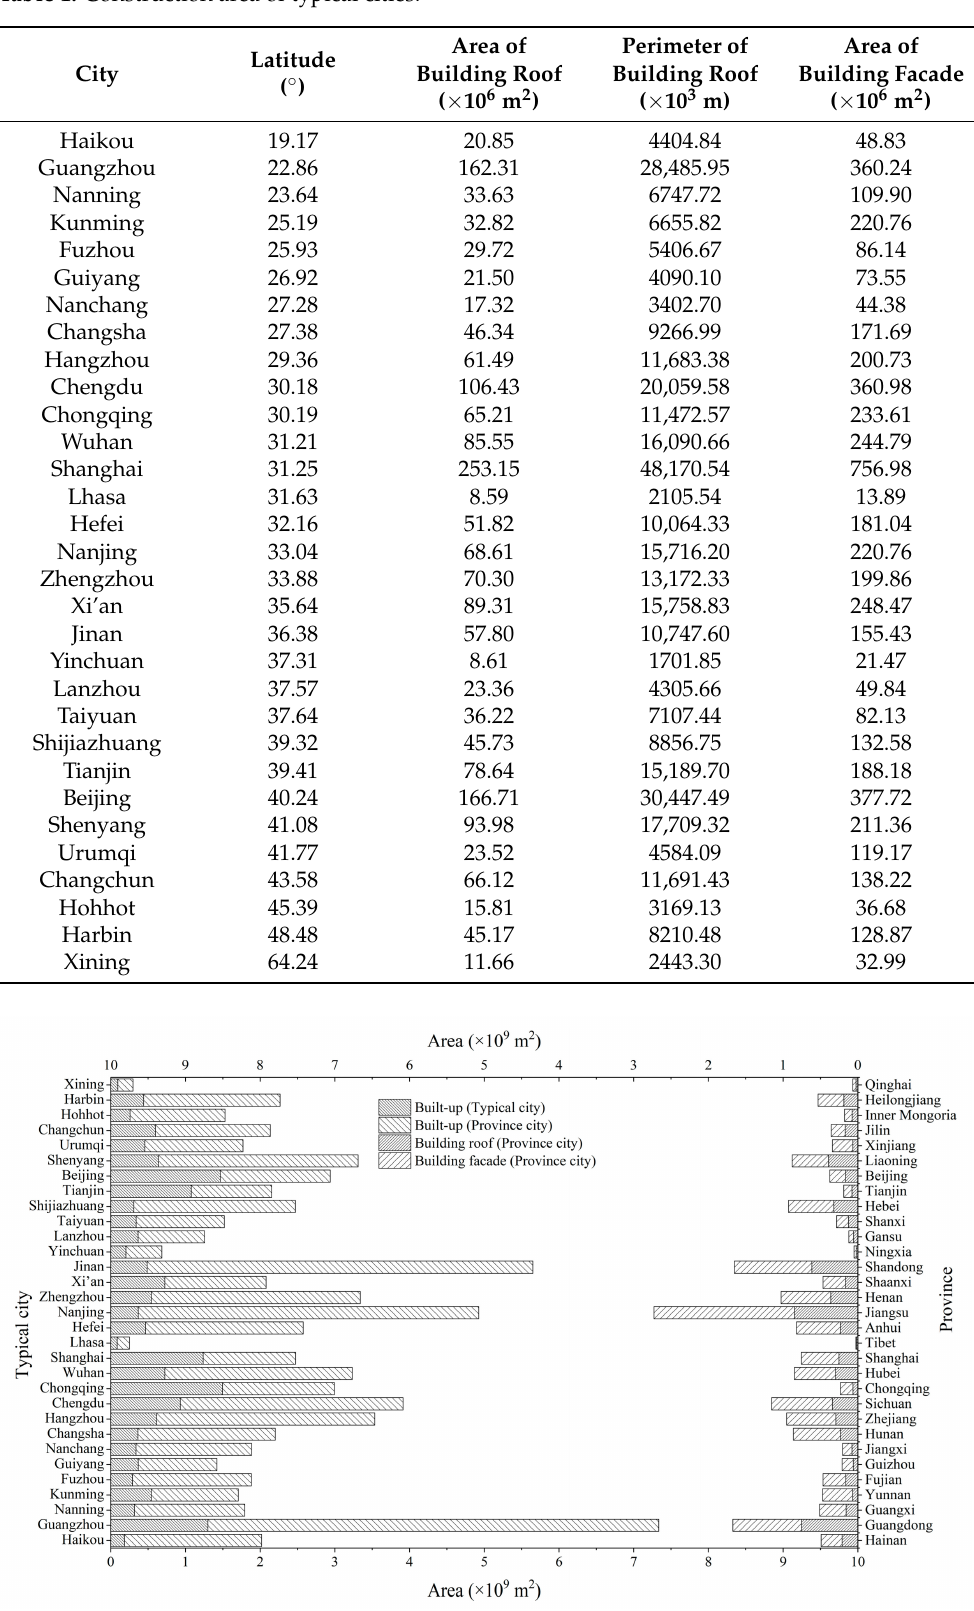
Table 1. Construction area of typical cities.